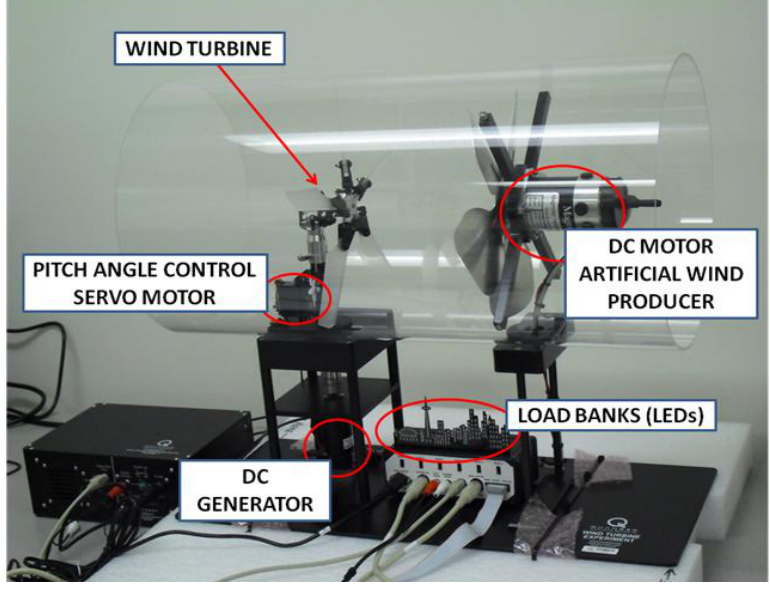
Figure 1. Wind turbine experiment workstation by Quanser Inc.